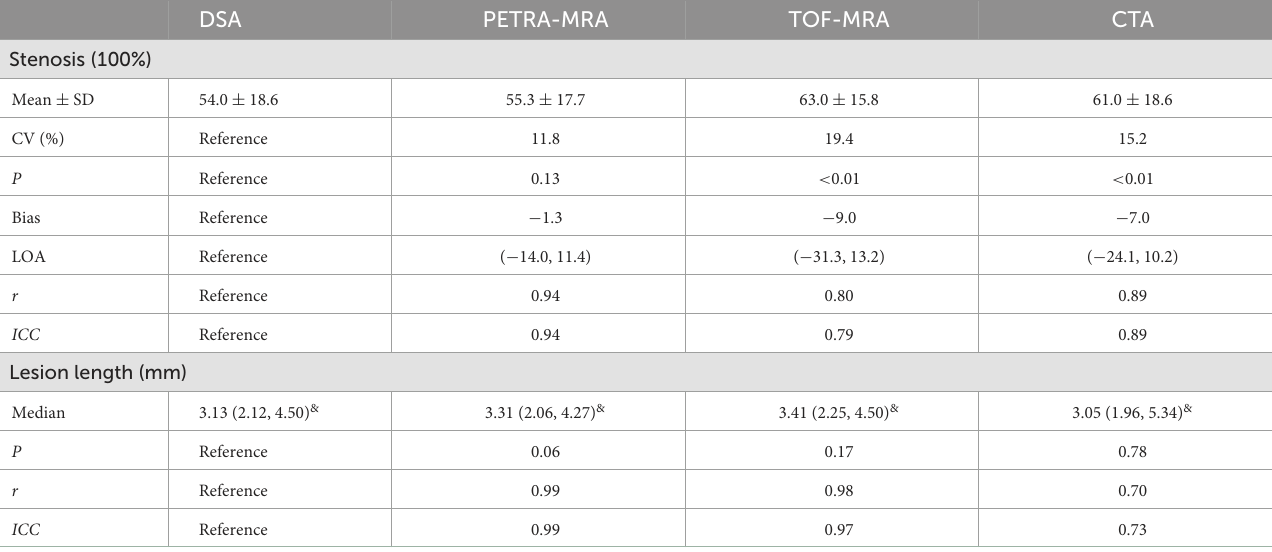
TABLE 1 Comparison of MRAs/CTA and DSA in measuring the degree of stenosis and lesion length. DSA PETRA-MRA TOF-MRA